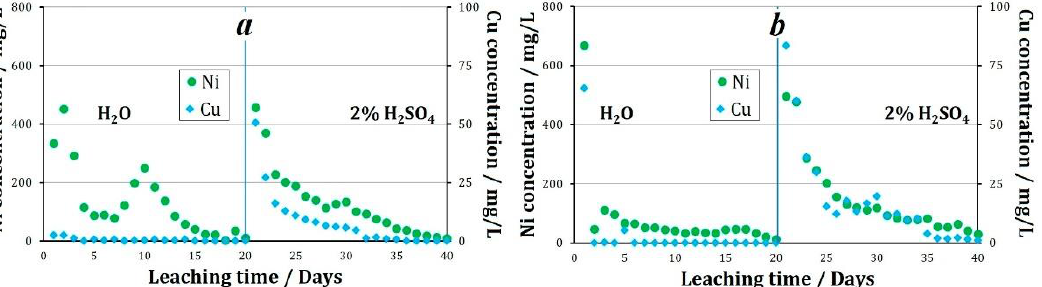
Figure 5. The concentration of metals in pregnant liquors during leaching of granules treated with oxidizer: ( a ) — 2% H 2 SO 4 + Fe 3+ , ( b ) — 2% H 2 SO 4 + NO 2 − .